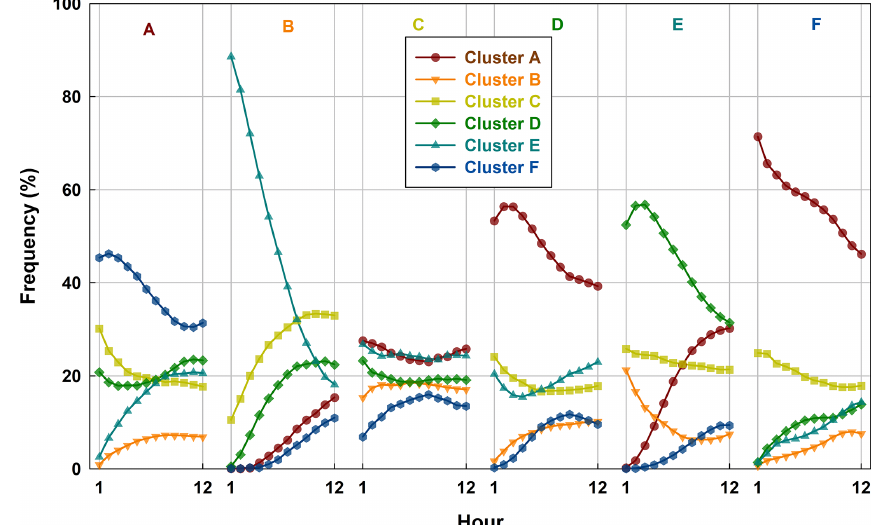
Figure 7. Occurrence frequency of the other clusters at the subsequent 1–12h after each cluster appeared during the entire measurement campaign. For example, the frequencies of clusters B, C, D, E and F in the subsequent 1–12h when Cluster A appeared (the first column of Fig. 7) can be calculated by the equation N A,i,j = N i,j / (cid:80) N i × 100% ( i = 1 , 2 ... 12 ,j represents the other clusters except Cluster A, i.e., clusters B, C, D, E and F). The calculation is similar when the other clusters appeared during the